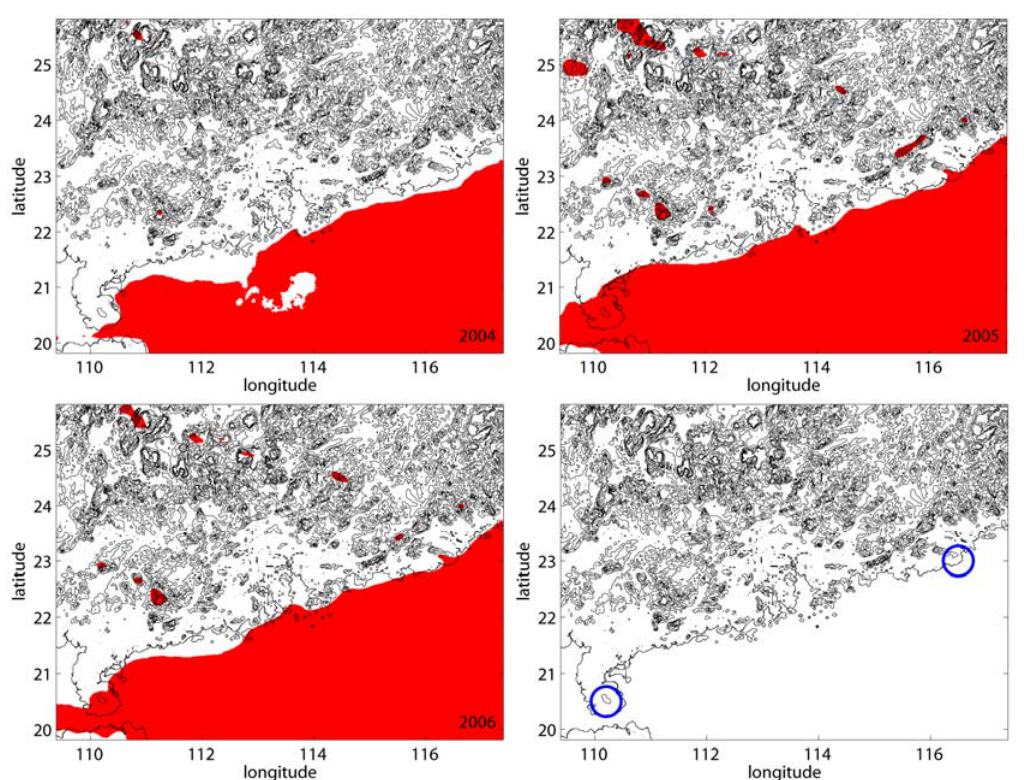
Figure 12. Frequency of wind speed greater than 5 m/s where red colour represents frequency greater than 70%. Blue colour circles identify onshore high wind resource